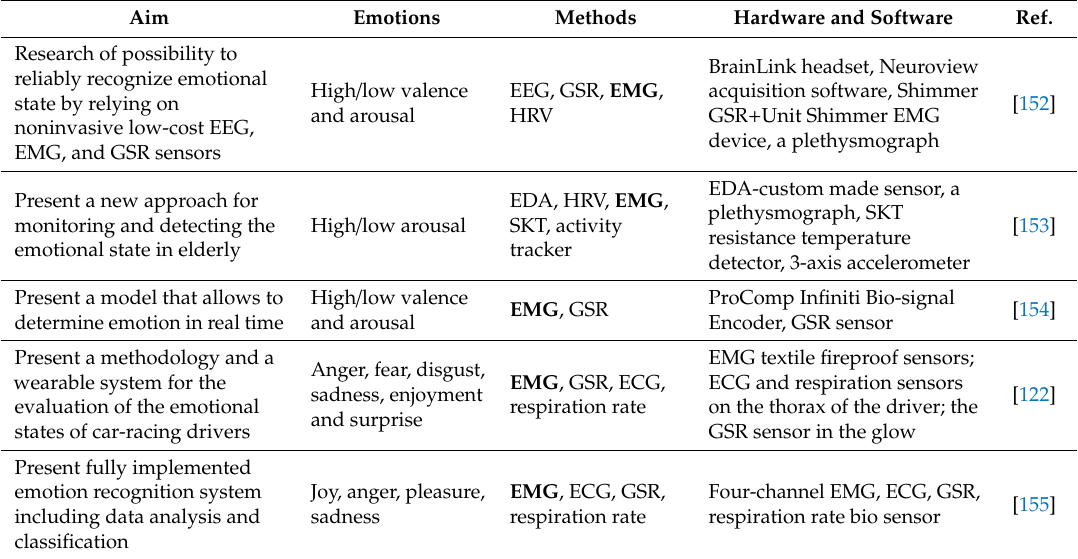
Table 10. Review of scientific researches focused on emotions recognition and evaluation using EMG. Aim Emotions Methods Hardware and Software